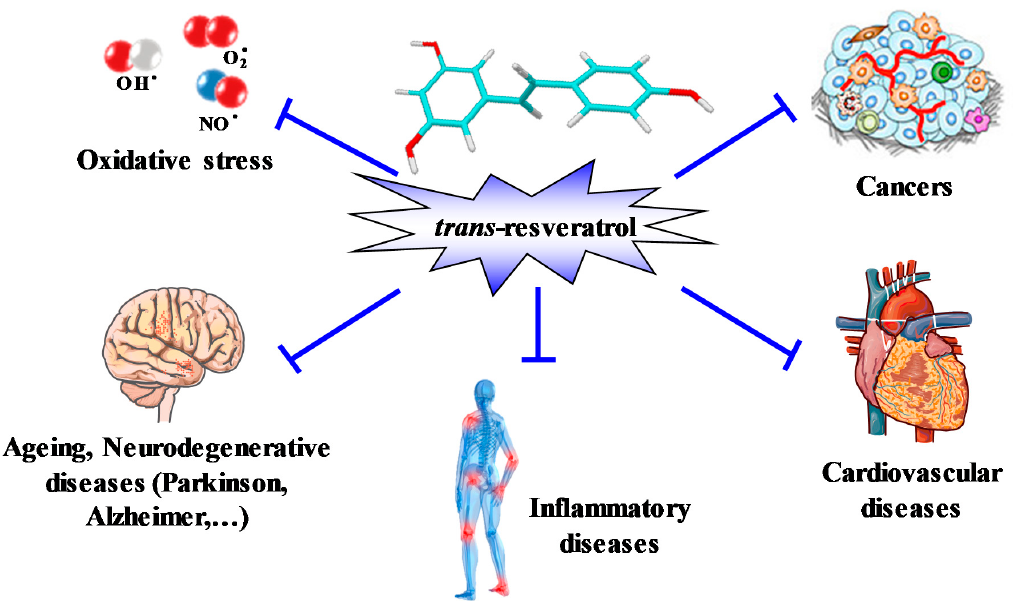
Figure 2. Pleiotropic action of RSV. The 3,4 ′ ,5-trihydroxystilbene is able to prevent coronary heart diseases, inflammatory pathologies, oxidative stress in aging, neurodegenerative diseases, as well as cancers.